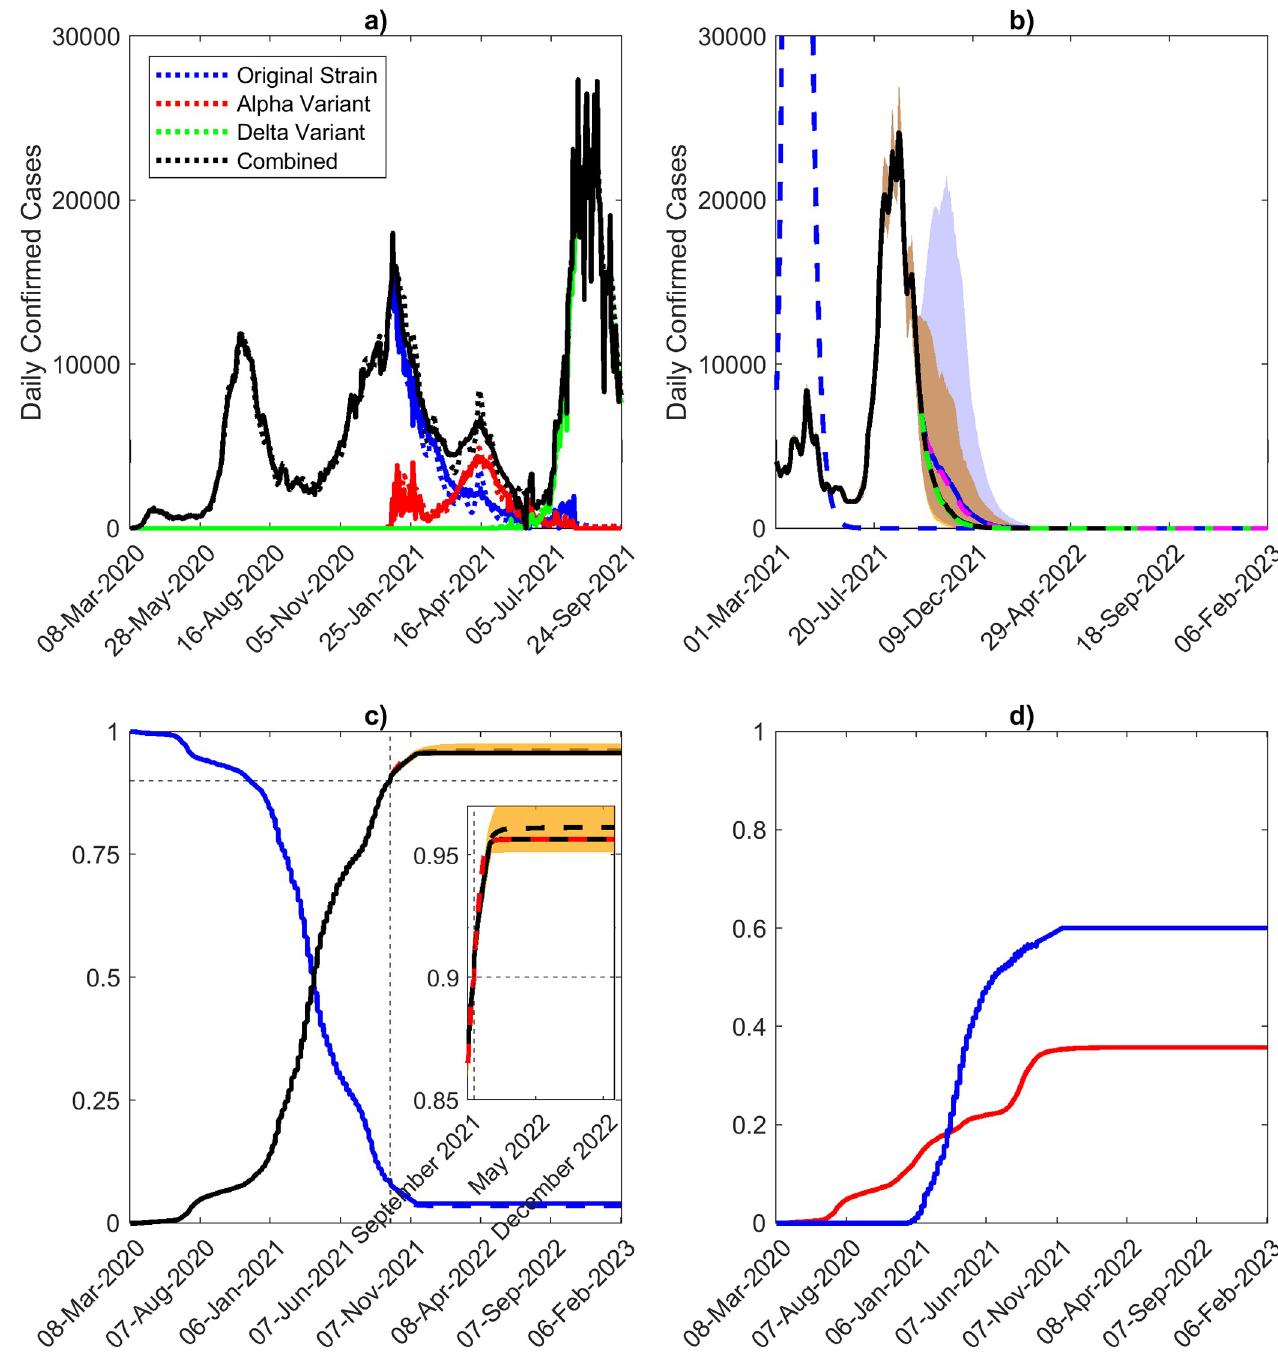
Fig 2. Model fits and long-term predictions. a) Median model fits to the 7-day moving average of daily confirmed case data, along with short-term predictions, assuming long-term immunity. The cases due to the alpha, delta, and other variants are given in red, green, and blue, respectively. b) Long-term forecasts of daily confirmed cases until February 2023. The 7-day moving average of confirmed case data is given in red. The median model predictions given estimates of social distancing measures and vaccination rate as of Sept. 24 th 2021 are given by the black curve, while the model predictions given a full release of social distancing measures are given by the blue curve. The yellow and blue shading represent the 90% confidence intervals for these two scenarios. If the vaccination rate is increased by 1.5x, the median model prediction given social distancing measures estimated on Sept. 24 th 2021 is given by the green dashed curve, while in the case of full release of social measures, it is given in magenta. The blue dashed line represents a full release of social measures on Mar. 1 st 2021, when the fraction of immunity was much lower than present, which produces a peak of 250,000 daily confirmed cases (assuming social measures are not modified). c) Total proportion susceptible (blue), and total immune (black) over time. The proportion immune given estimates of social measures and